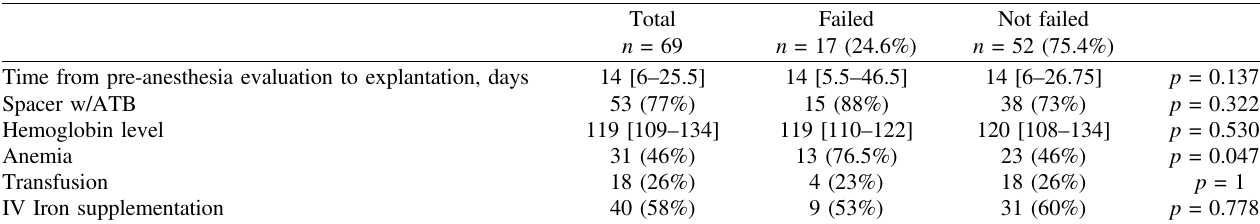
Table 4. Explantation surgery data.